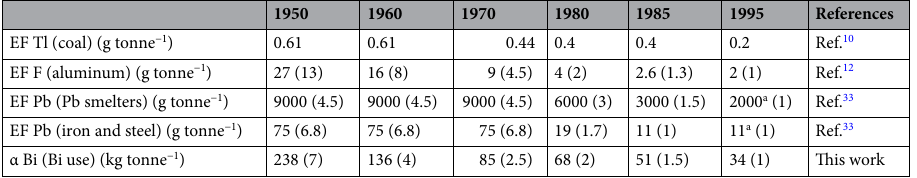
Table 1. Estimated emission factors (EFs) of Tl for coal burning, F from Al production, Pb from Pb smelters, and Pb from steel production in Europe from the 1950s to the 1990s and comparison with the amount of Bi that was assumed to be emitted per tonne of consumed (processed) Bi in the 1990s in this study (α, see “Methods”). Values under parenthesis refer to the increase of EF (or α) relative to the 1995 value. a Estimated from ref. 1